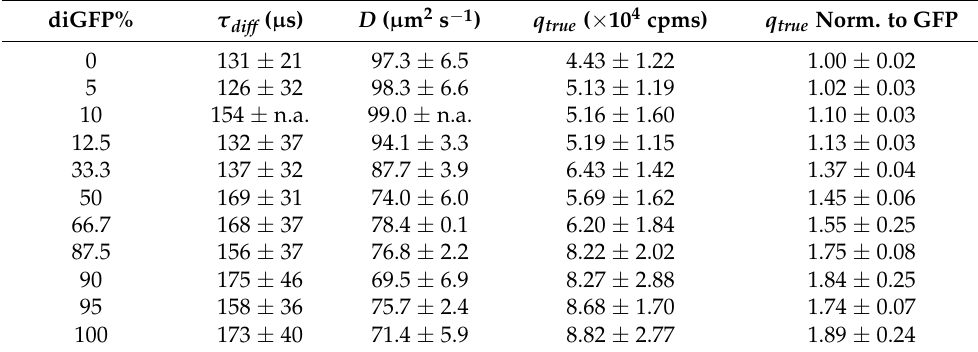
Percentages of diGFP particles are indicated, relative to the total number of GFP and diGFP particles in the sample. The presented values are mean ± standard deviation (SD) based on 42–126 traces from 2–5 measurement days. τ diff : diffusion parameter before any normalization; D : diffusion coefficient calculated from τ diff , corrected for the diffusion of R110 on each measurement day; q true : average true brightness without any correction for instrumental variation between days; q true norm. to GFP: true brightness normalized for the true brightness of the GFP sample per measurement